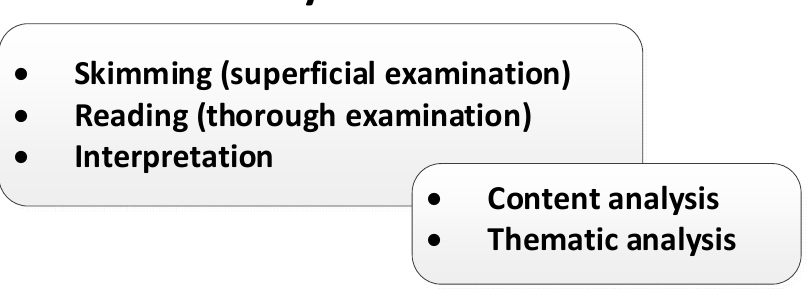
Figure 4. The process of document analysis [31].